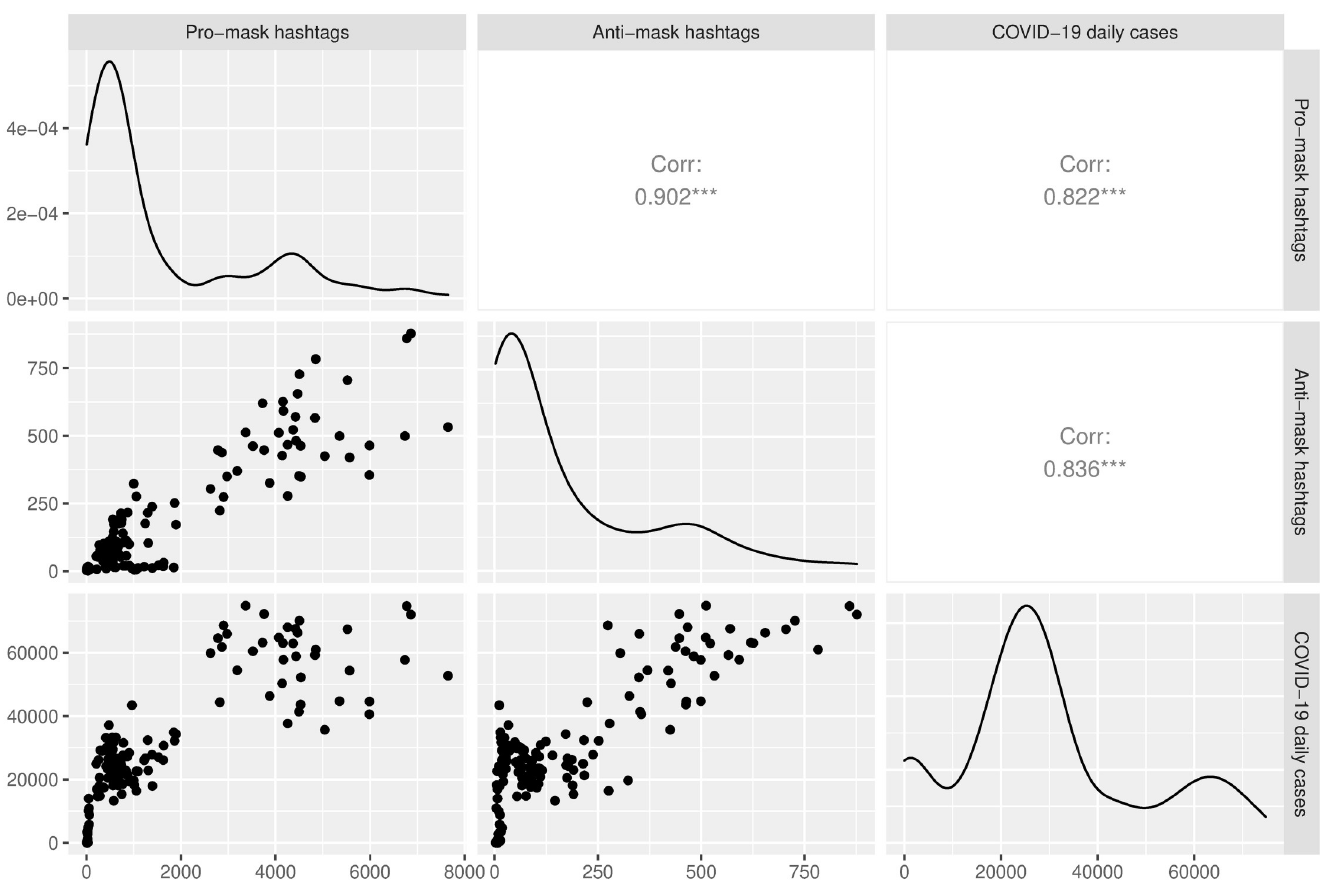
Fig 7. Correlation matrix of the time series of pro-mask hashtags, anti-mask hashtags, and daily confirmed COVID-19 cases. On the diagonal are shown the density plots, which visualize the distributions of the three variables over continuous intervals, with hashtag/case counts on the horizontal axis and number of days (normalized) using kernel probability estimation on the vertical